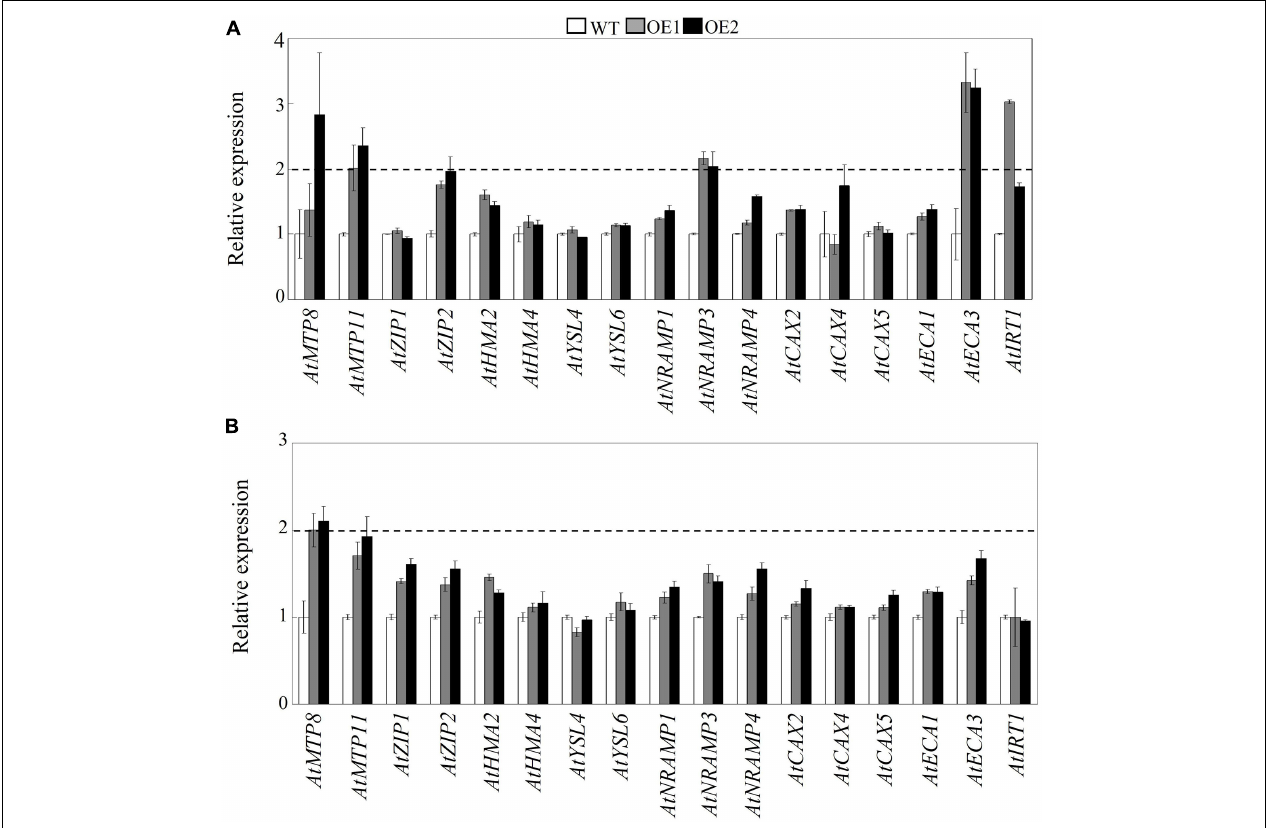
FIGURE 9 | Effects of GmMTP8.1 overexpression on the transcript levels of Mn transporter genes in Arabidopsis. (A) Gene expression in leaves. (B) Gene expression in roots. Seven-day-old seedlings were transferred to a solid MS medium containing 4 mM MnSO 4 for 7 days. Leaves and roots were sampled for RNA extraction and real-time (RT)-polymerase chain reaction (PCR) analysis. WT represents the wild type Arabidopsis. OE1 and OE2 are two transgenic lines overexpressing GmMTP8.1 . Each bar represents the mean value of three independent replicates with standard error. White, gray, and black bars represent WT, OE1, and OE2, respectively. The relative expression level of gene of more than 2-fold was regarded as significant difference between the wild type and the overexpression